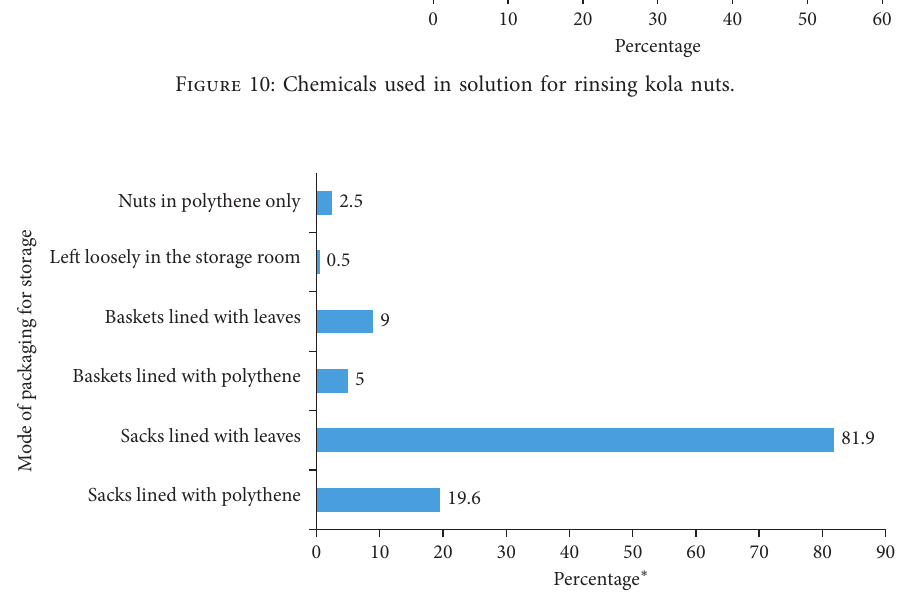
Figure 11: Packaging kola nuts for storage ( ∗ multiple responses).